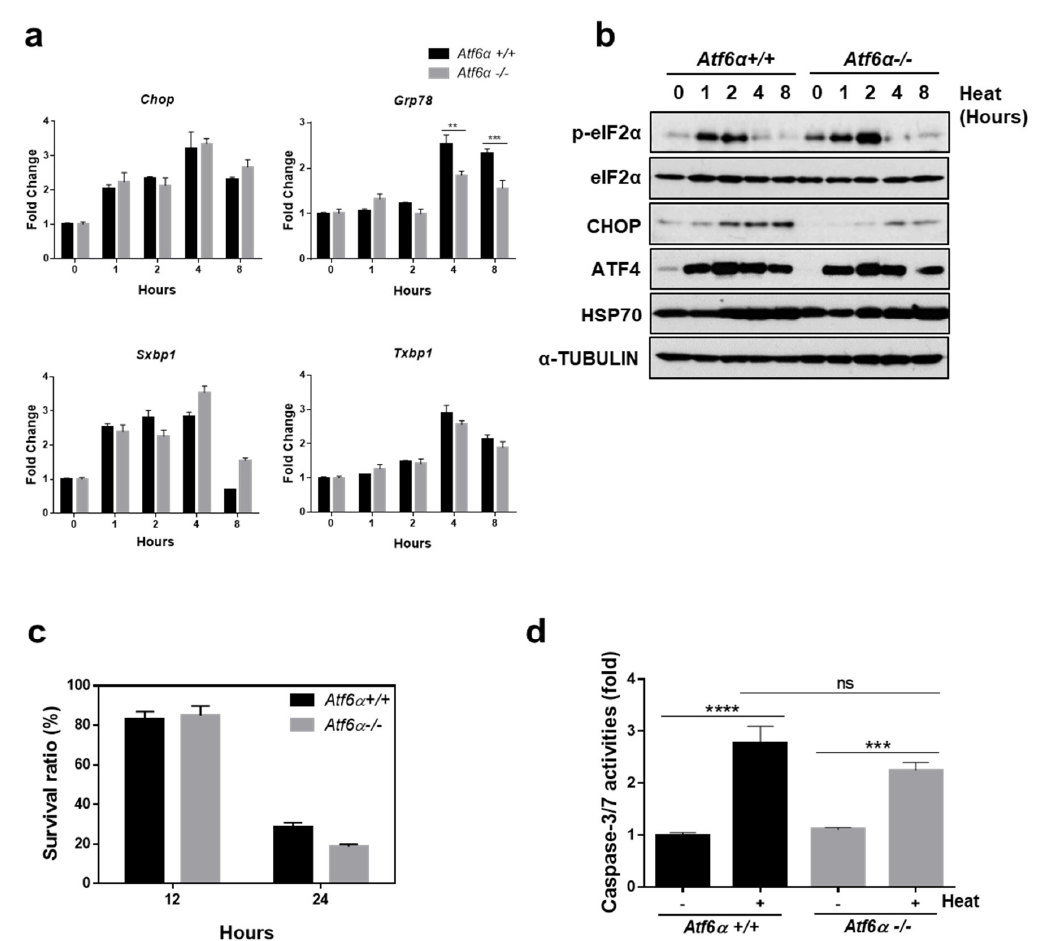
Figure 3. The ATF6 α pathway does not protect cells from heat stress-mediated death. ( a ) Quantitative Figure 3. The ATF6α pathway does not protect cells from heat stress-mediated death. (a) Quantitative RT-PCR was performed using total RNA extracted from Atf6 α − / − and Atf6 α +/+ MEFs which were RT-PCR was performed using total RNA extracted from Atf6α −/− and Atf6α +/+ MEFs which were incubated at 42 ◦ C for indicated time periods. Data are presented as means ± SEM (n = 3 incubated at 42 °C for indicated time periods. Data are presented as means ± SEM (n = 3 independent